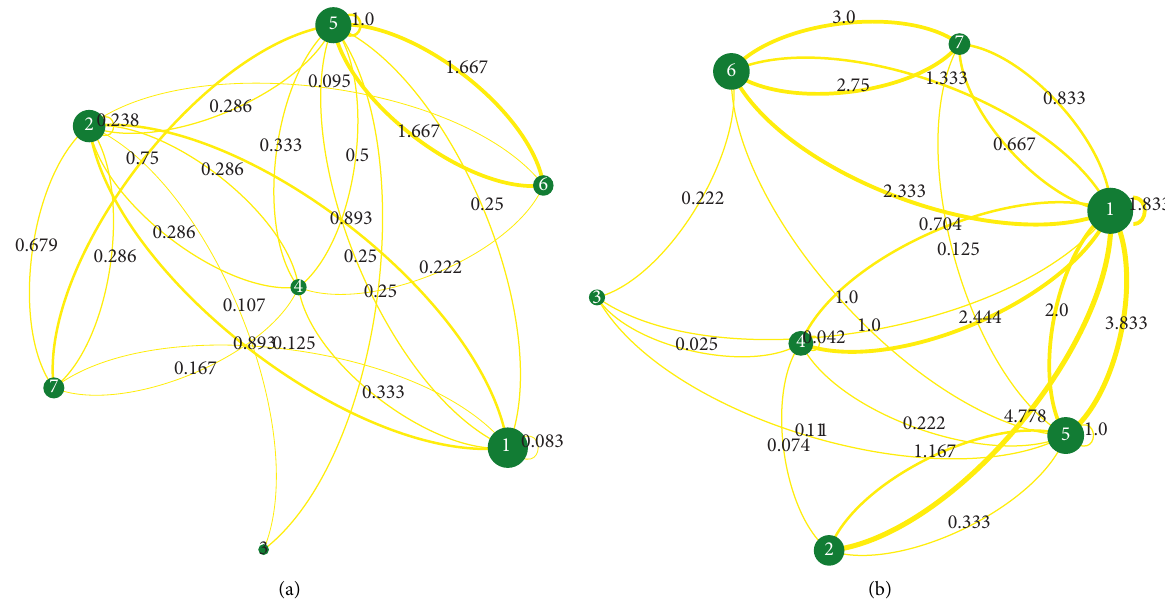
Figure 5: Connectivity intensity of freight network communities in urban agglomerations in the middle reaches of the Yangtze river in 2014 (a) and 2018 (b). (Notes: the size of the ○ in the figure represents the weighted average node degree of the community, and the thickness of the line represents the contact density value between